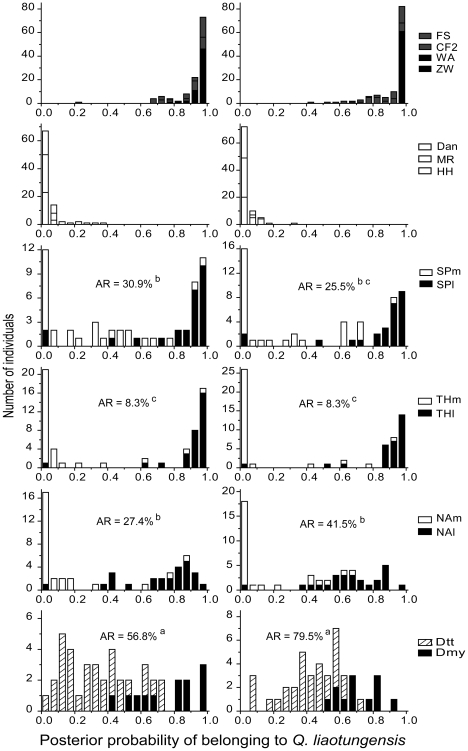
Distribution of ancestry estimates in each study site.The ancestry is based on posterior probability of belonging to Quercus liaotungensis at K = 2 in the STRUCTURE analysis using 19 SSR loci (left) or 194 AFLP markers (right). AR =  admixture rate according to the STRUCTURE assignment analysis, with the superscript a, b and c indicating statistically significant differences.